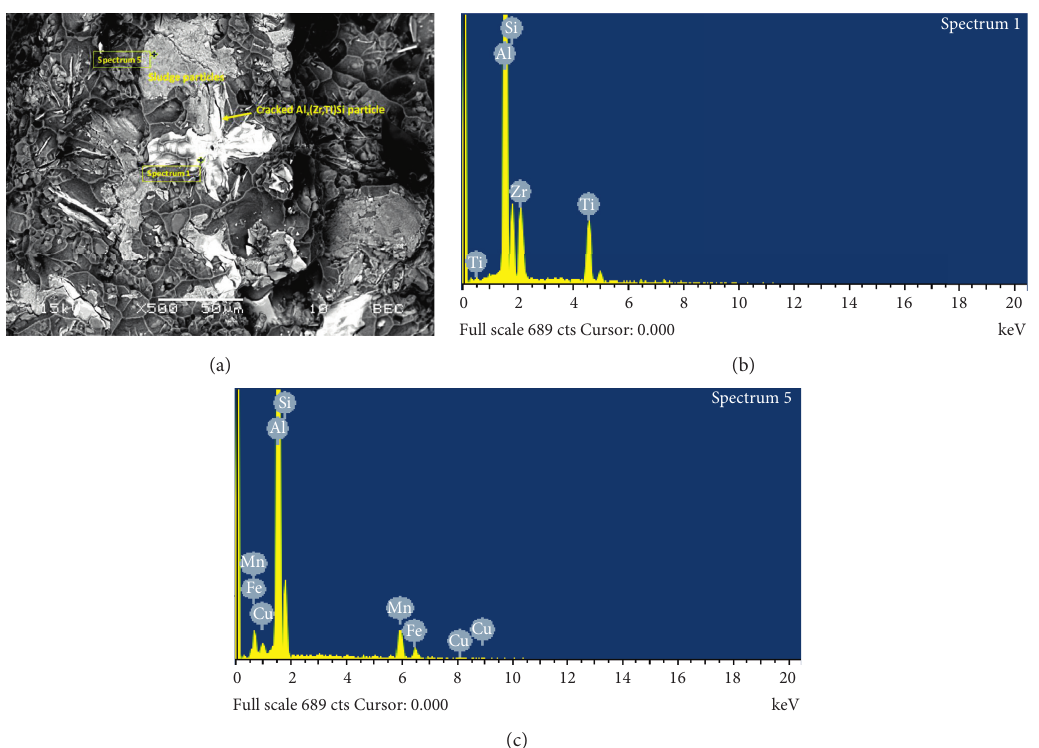
Figure 10: (a) BSE image of T6-treated M3S alloy after stabilization at 250 ° C for 200 hours showing the dimple structure (upper right corner), coarsened precipitates and a cracked star-like Al-Si-Ti-Zr and sludge particles and (b), (c) EDS spectra corresponding to the Al-Si- Ti-Zr and sludge particles shown in